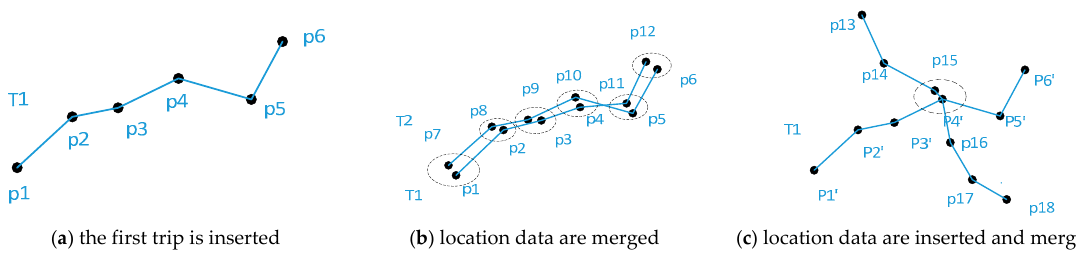
Figure 2. Road network construction process diagram. ( a ) The first trip is inserted, ( b ) the second trajectory is inserted and integrated with existing nodes, and ( c ) the third trip is inserted and the merging method is used according to the position of the point that is being inserted.